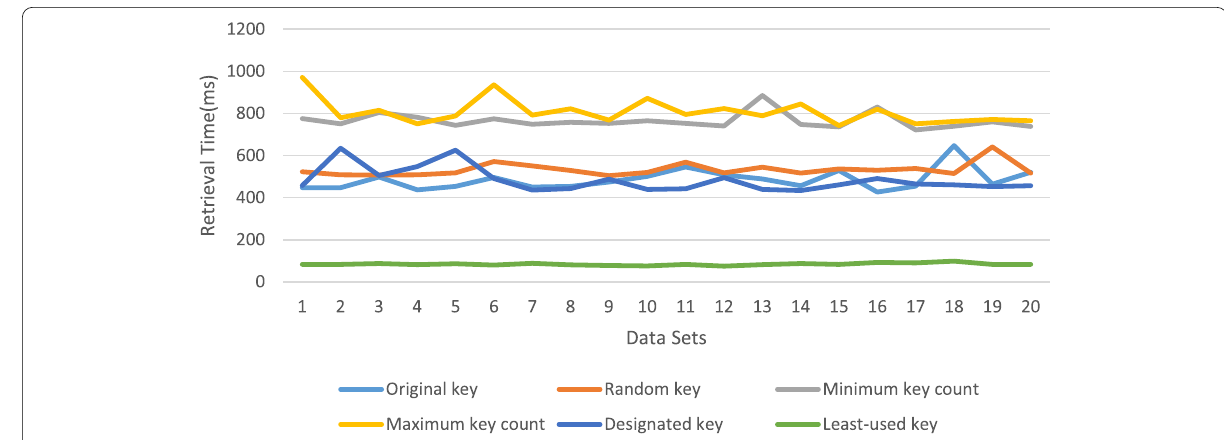
Fig. 17 Retrieval time on full index models generated using the six different key selection methods with unequal appearing probabilities of parameters in service retrieval